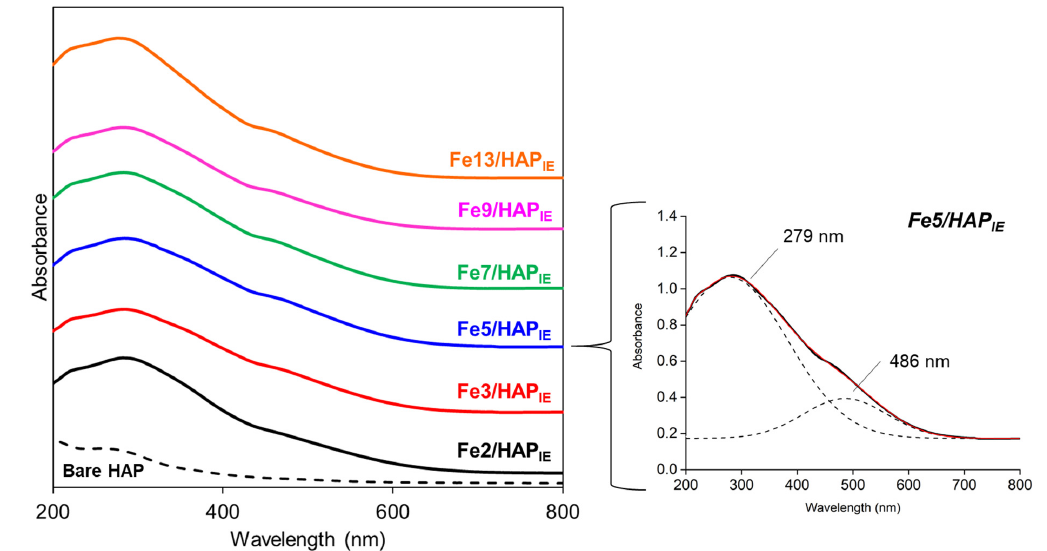
Figure 5. UV-vis DR spectra of Fe / HAP samples and bare HAP (left); deconvoluted spectrum of Fe5 / HAP IE (right): calculated curve, red line, and decomposed curves, dotted black line with the related peak centers), chosen as an example.